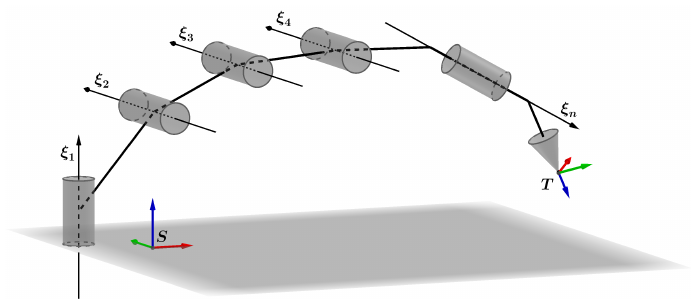
Figure 2. A general serial robot with n